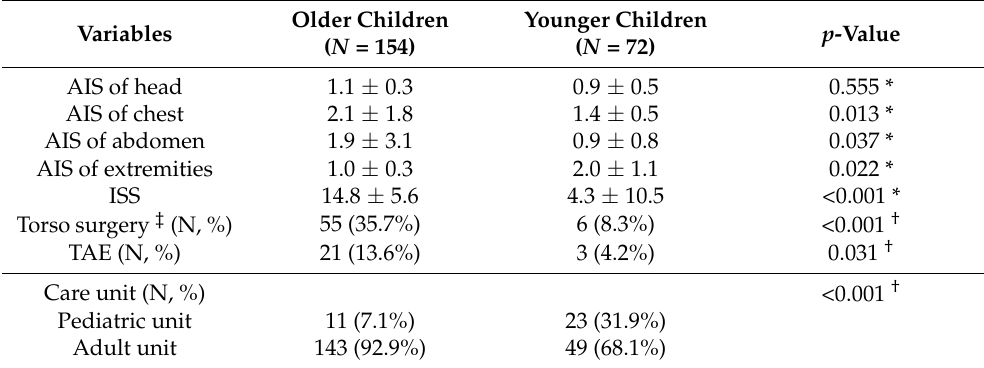
Table 4. Comparisons between older children and younger children with torso trauma ( N = 226). Older Variables